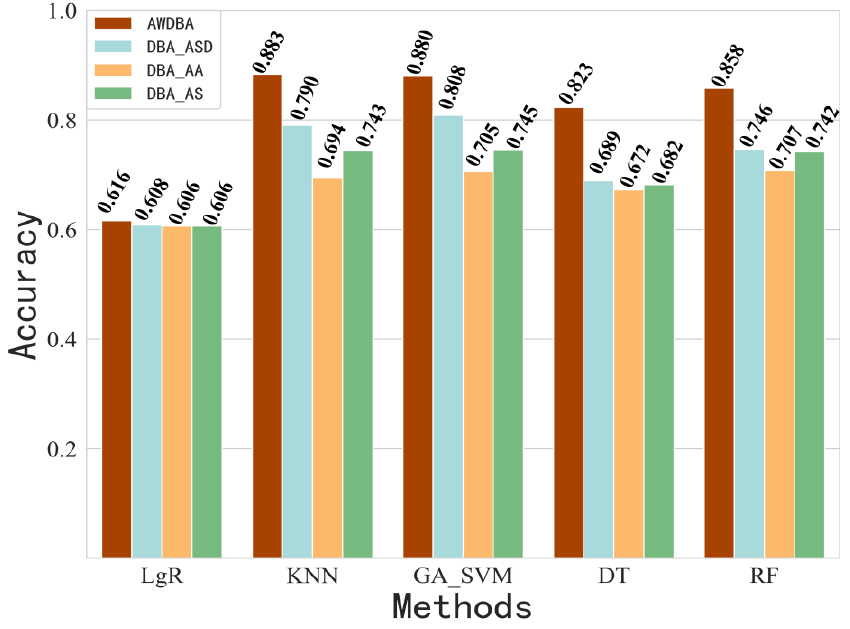
Figure 9. Accuracy of DBA using AA, AS, and ASD weight techniques compared with that of AWDBA.